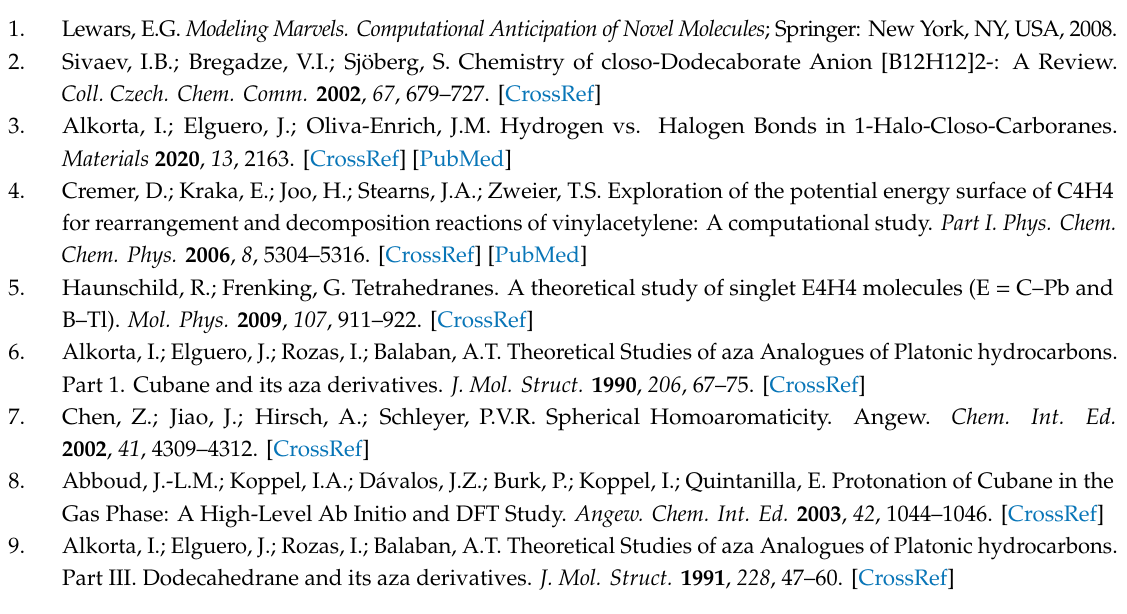
Supplementary Materials: The following are available online, Table S1: Structures (Å), total energies (a.u.), and molecular graphs of P(CH) 3 and XY:P(CH) 3 complexes A ; Table S2: Structures (Å), total energies (a.u.), and molecular graphs of complexes B ; Table S3: Structures (Å), total energies (a.u.), and molecular graphs of complexes C . Table S4: Structures (Å), total energies (a.u.), and molecular graphs of complexes D ; Table S5: PSO, DSO, FC, and SD components of total J for complexes A , B , C , and D ; Figure S1: 2h J(F-P) (Hz) versus the F-P distance (Å) for FH:P(CH) 3 A along the F-P intrinsic reaction path; Figure S2: 1x J(Cl-P) (Hz) versus the Cl-P distance (Å) for FCl:P(CH) 3 A along the Cl-P intrinsic reaction path; Fig: S3. Dipole alignments in the isomers C and D for ClH:P(CH) 3 ;Table S6: 1 J(P-C) (Hz) for P-C bonds of P(CH) 3 that do or do not interact with FH, ClH, and ClF in complexes A , B , C , and D ; Table S7: Structures (Å), total energies (a.u.), and molecular graphs of transition